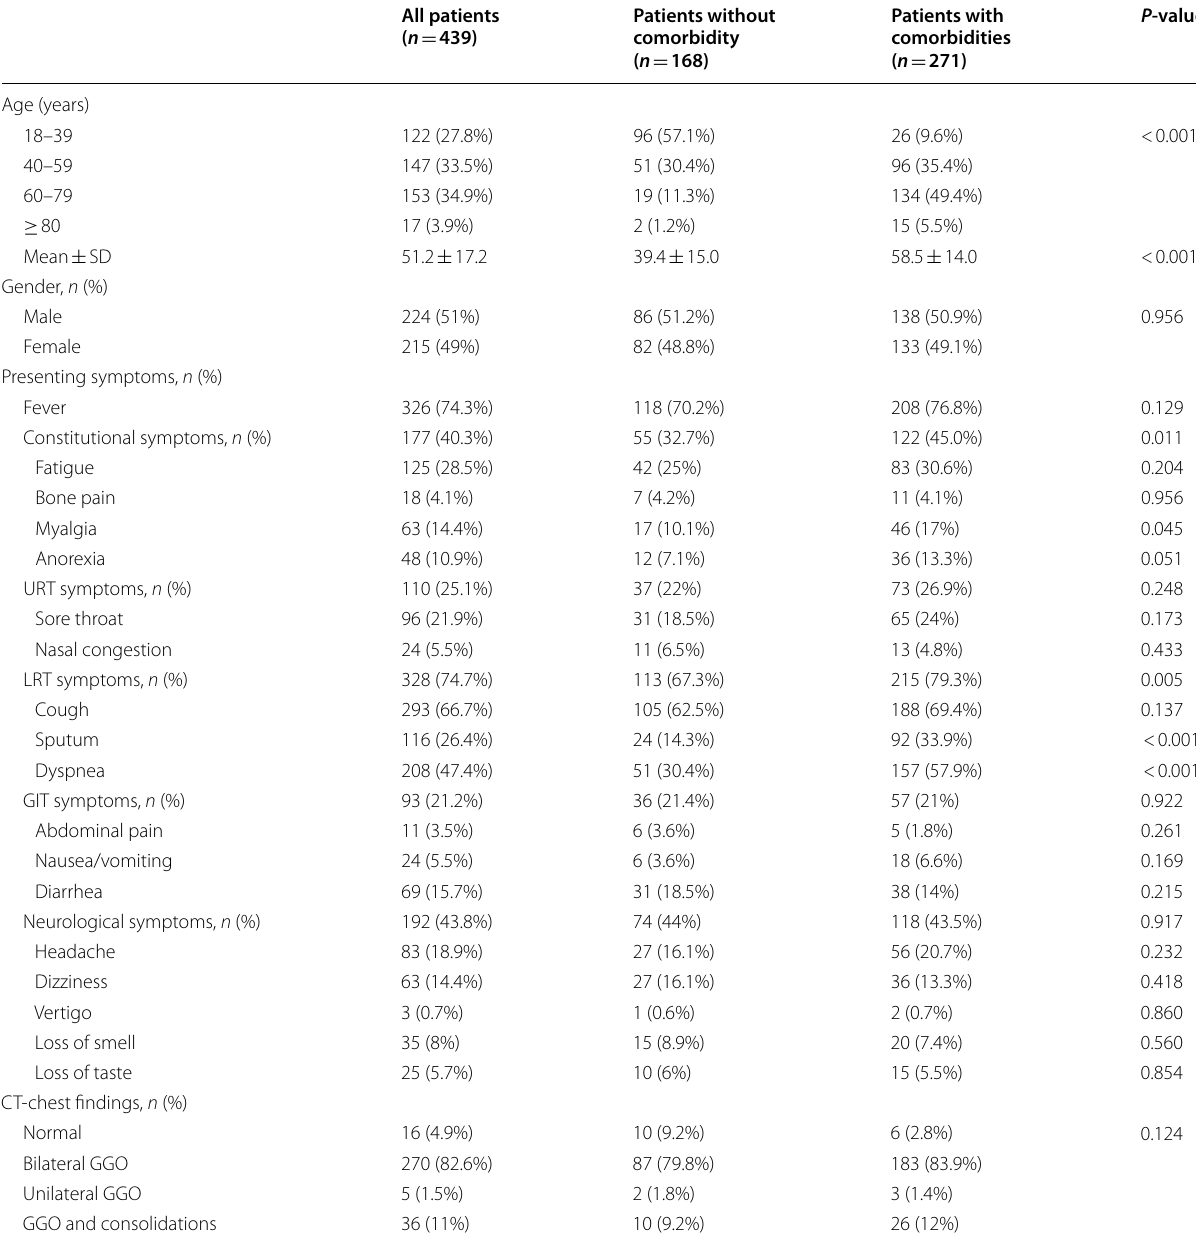
Table 1 Demographic and clinical characteristics of COVID‑19 patients included in the study ( n